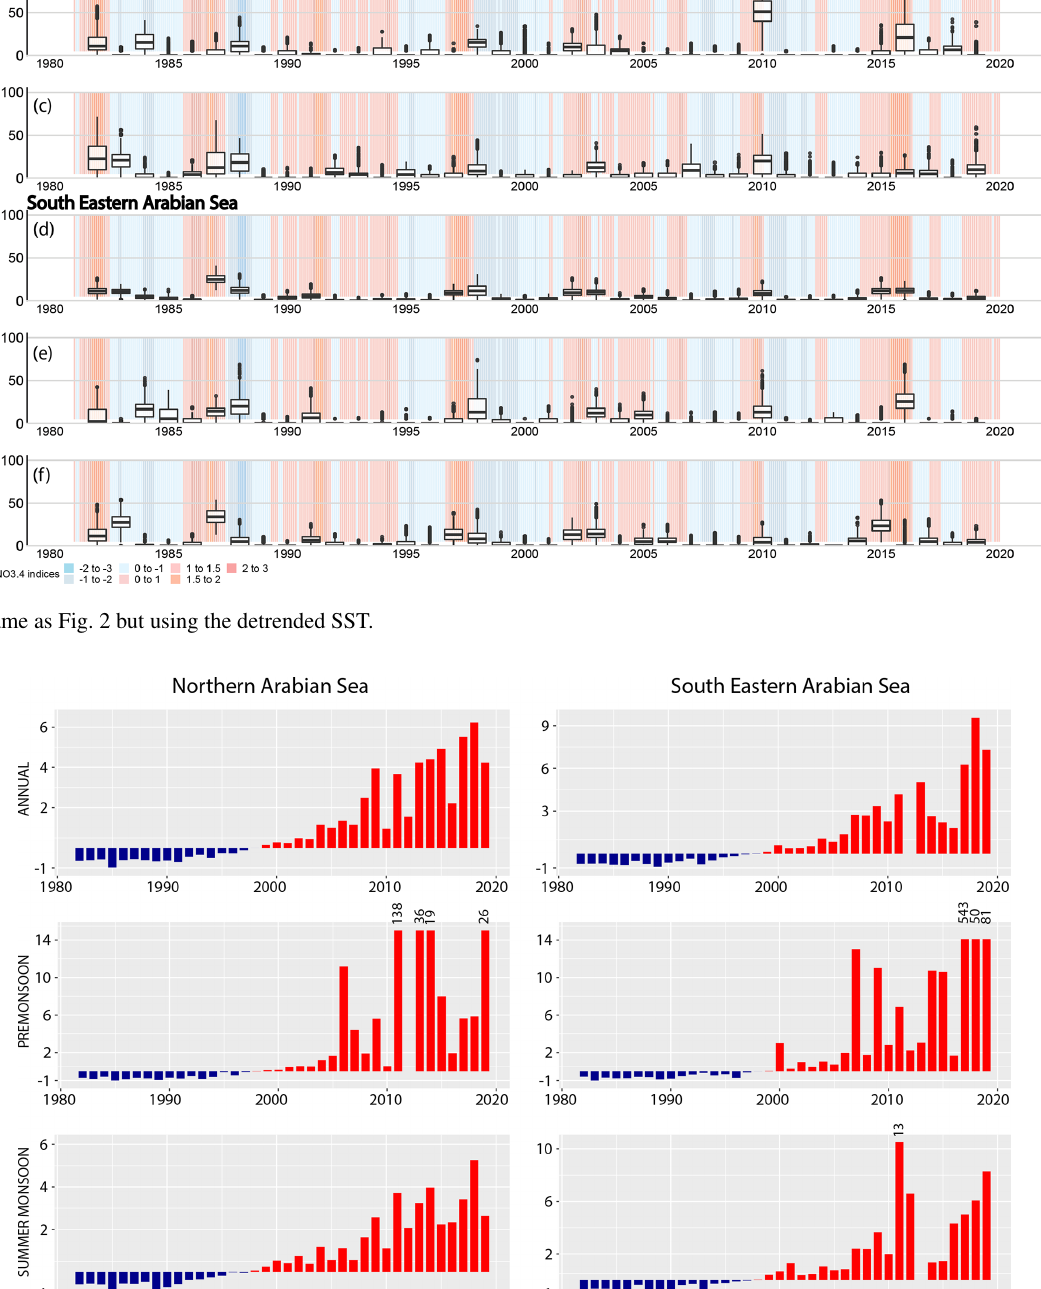
Figure 6. Ratio of MHW days derived using SST and detrended SST based on Eq. (3). Note that a few bars are truncated and the actual ratio is written at the top of the corresponding